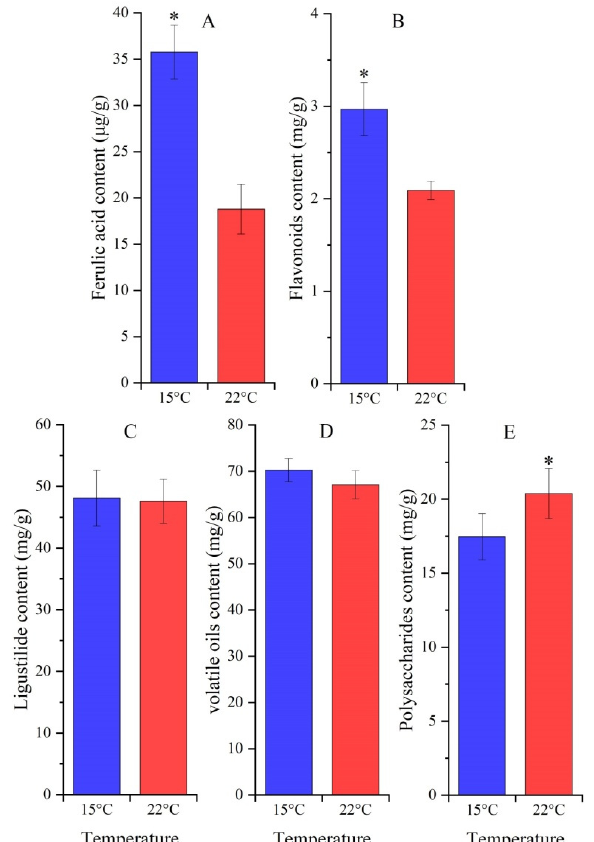
Figure 3. Metabolites contents in A. sinensis treated with cool temperature (mean ± SD, n = 20). Images ( A , B ) represent the ferulic acid and flavonoids contents, ( C , D ) represent the ligustilide and volatile oils contents and ( E ) represents the polysaccharides content, respectively. “*” represents a significant difference ( p < 0.05) at different stages.